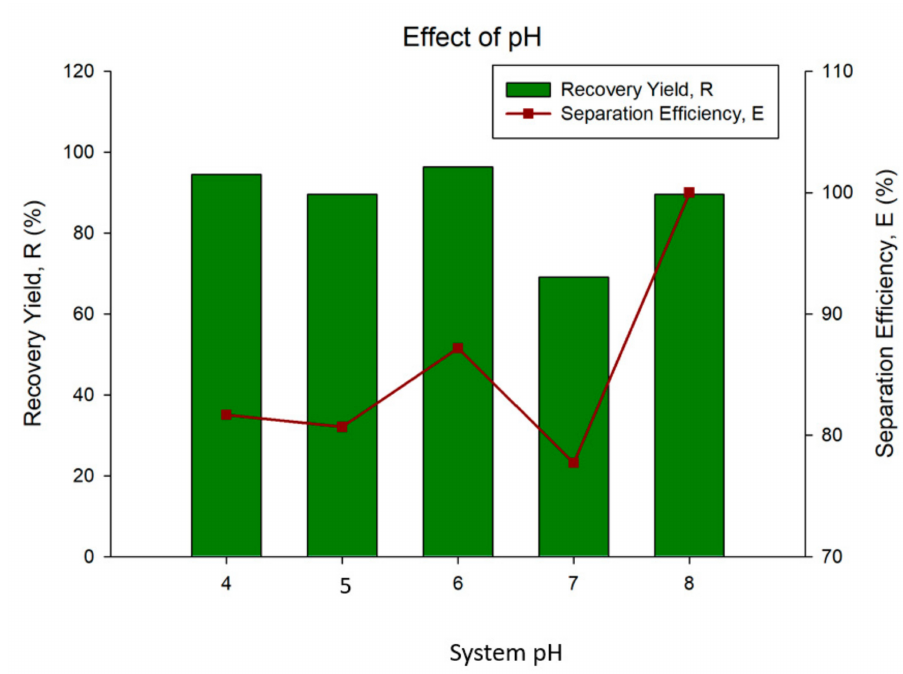
Figure 4. E ff ect of pH on the protein recovery yield and separation e ffi